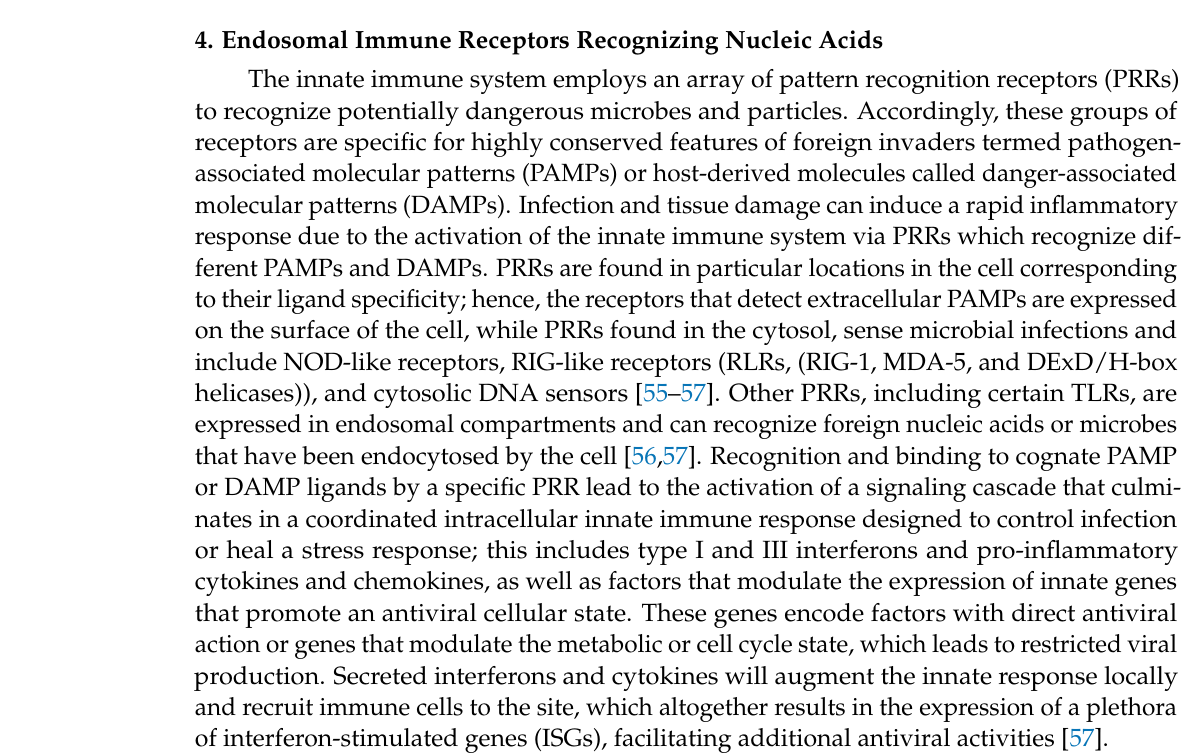
Gene silencing not always sequence dependent. Tumor suppression, T cell inhibition, affect virus replication and influence stress responses. Transfer RNAs are characterized by their typical cloverleaf structure which can be processed into abundant